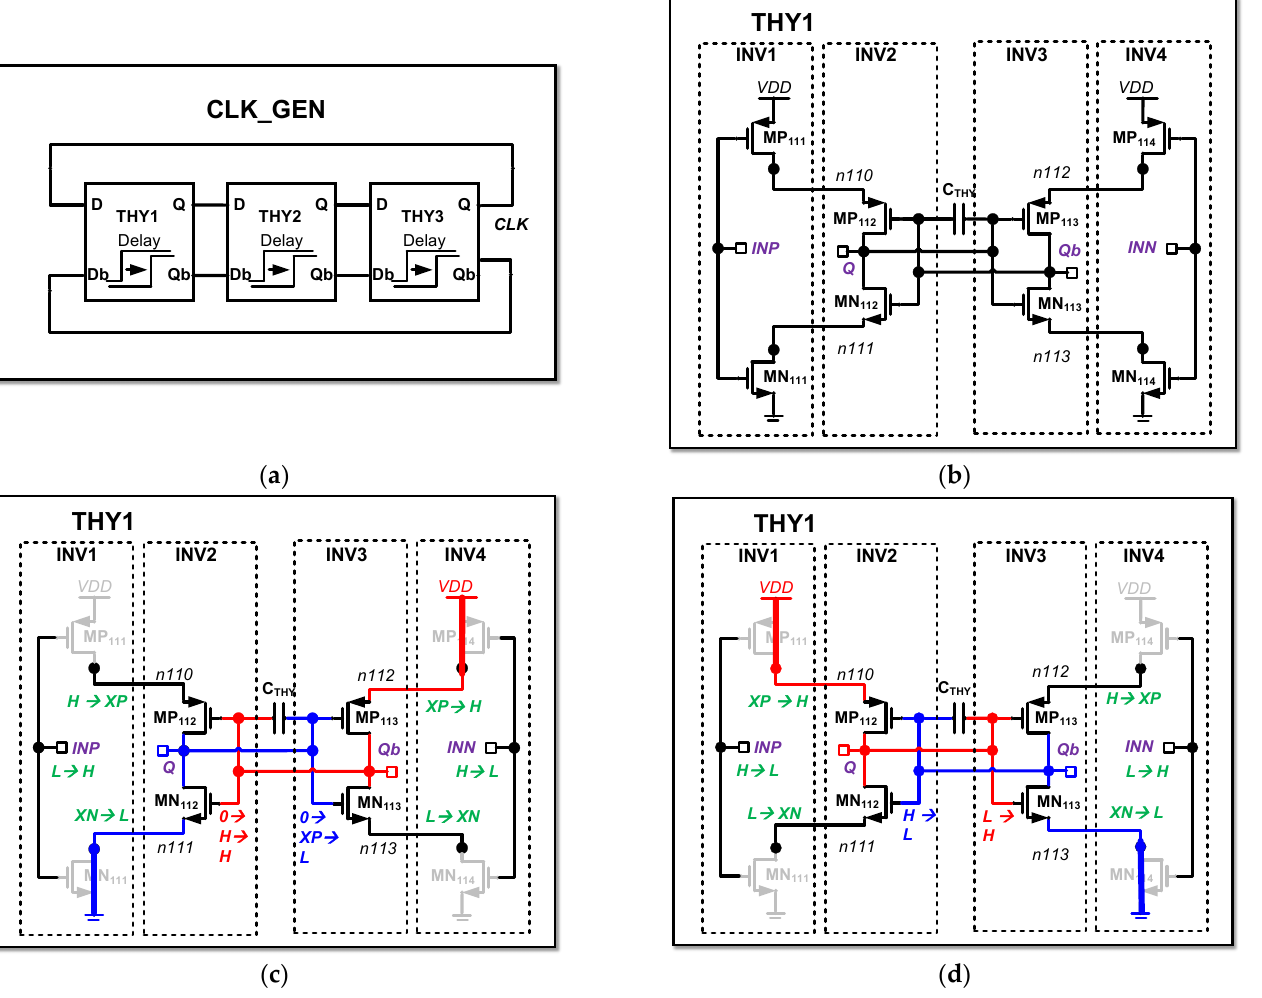
Figure 13. Detailed circuit diagram of CLK_GEN: ( a ) Configuration of CLK_GEN; ( b ) Detailed circuit of THY; ( c ) Operation voltage when INP becomes HIGH ; ( d ) Operation voltage when INP becomes LOW .